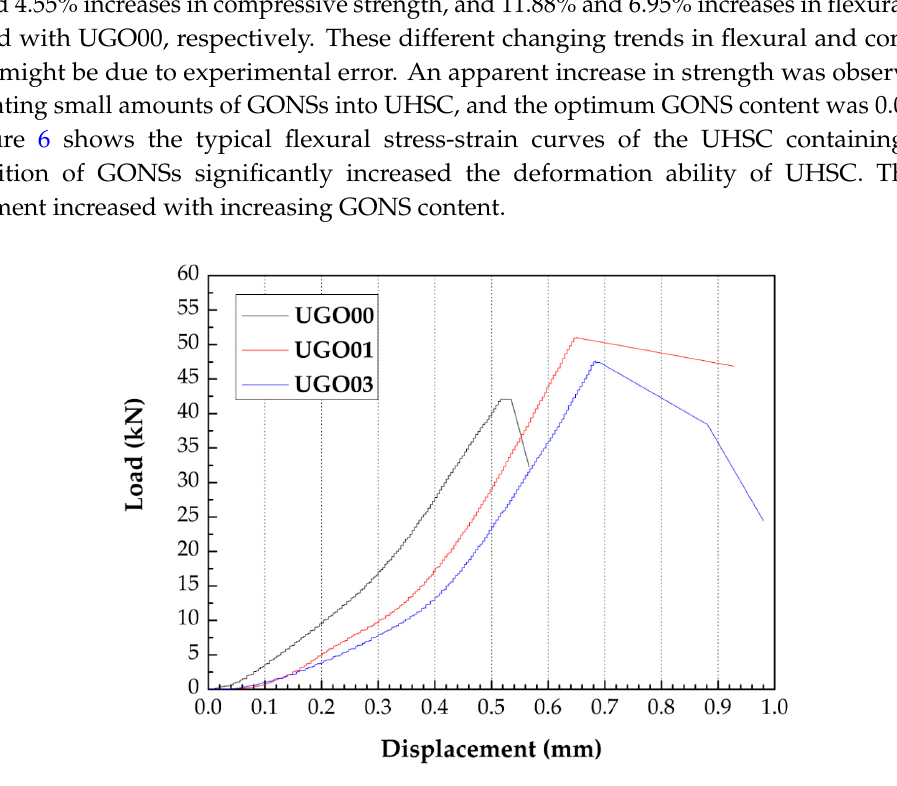
Figure 6. Load-displacement curves of GONSs-incorporated UHSC.